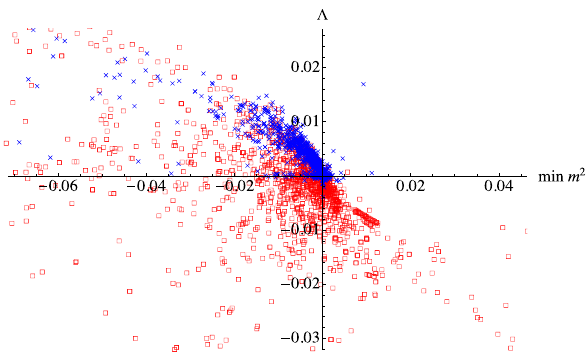
Fig. 6 Plot obtained by using non-penalty constraints (red points) and penalty constraints (blue